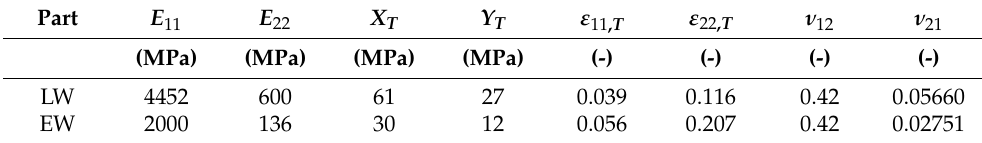
Table 3. Calibrated material parameter for in-plane shear behavior for EW and LW. Table 2. Calibrated material parameter in tensile loading direction for EW and LW obtained in [2].